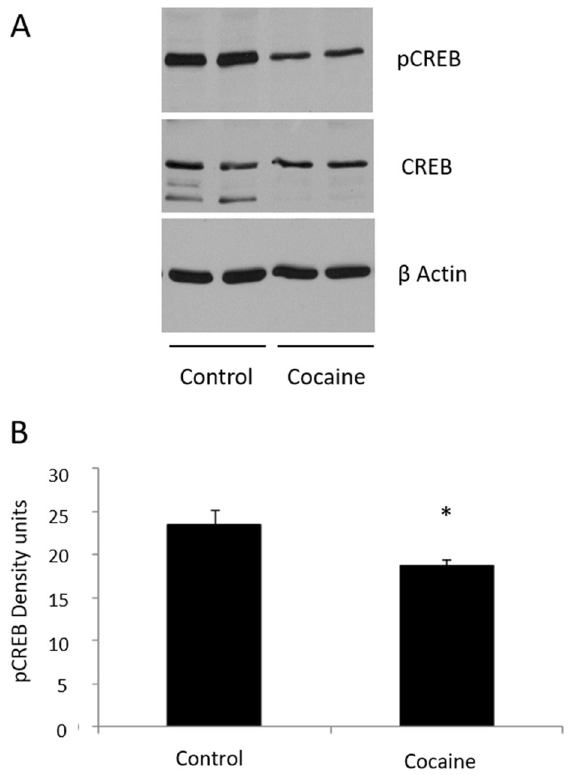
Figure 3. ( A ) pCREB (43 kDa), CREB (43 kDa) and β Actin (42 kDa) western blot in hippocampus (n = 8/6). ( B ) Representation of pCREB density units (pCREB/CREB ratio) in hippocampus. *p < 0.05 versus control group. Full-length blots are presented in Supplementary Figure 2. Samples derive from the same experiment and that gels/blots were processed in